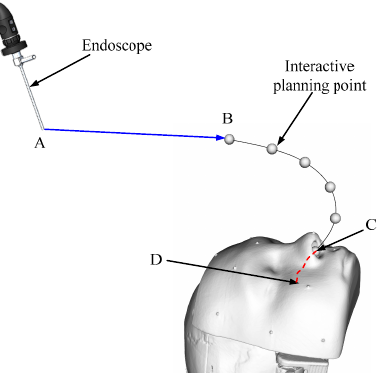
Figure 1. Trajectory of the endoscope at the end of the robot during endoscopic sinus surgery (taking the right maxillary sinus as an